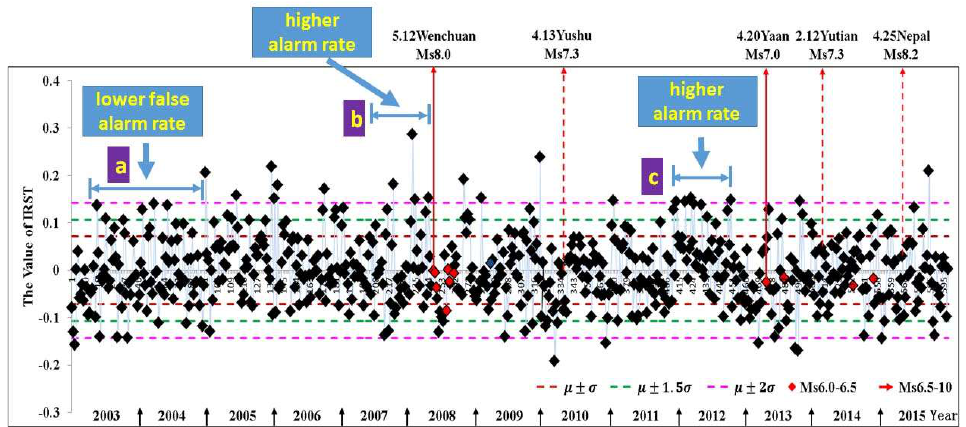
Figure 20. Tectonic TIR anomalies in time series extracted by the TTIA method in the Longmenshan Fault zone.